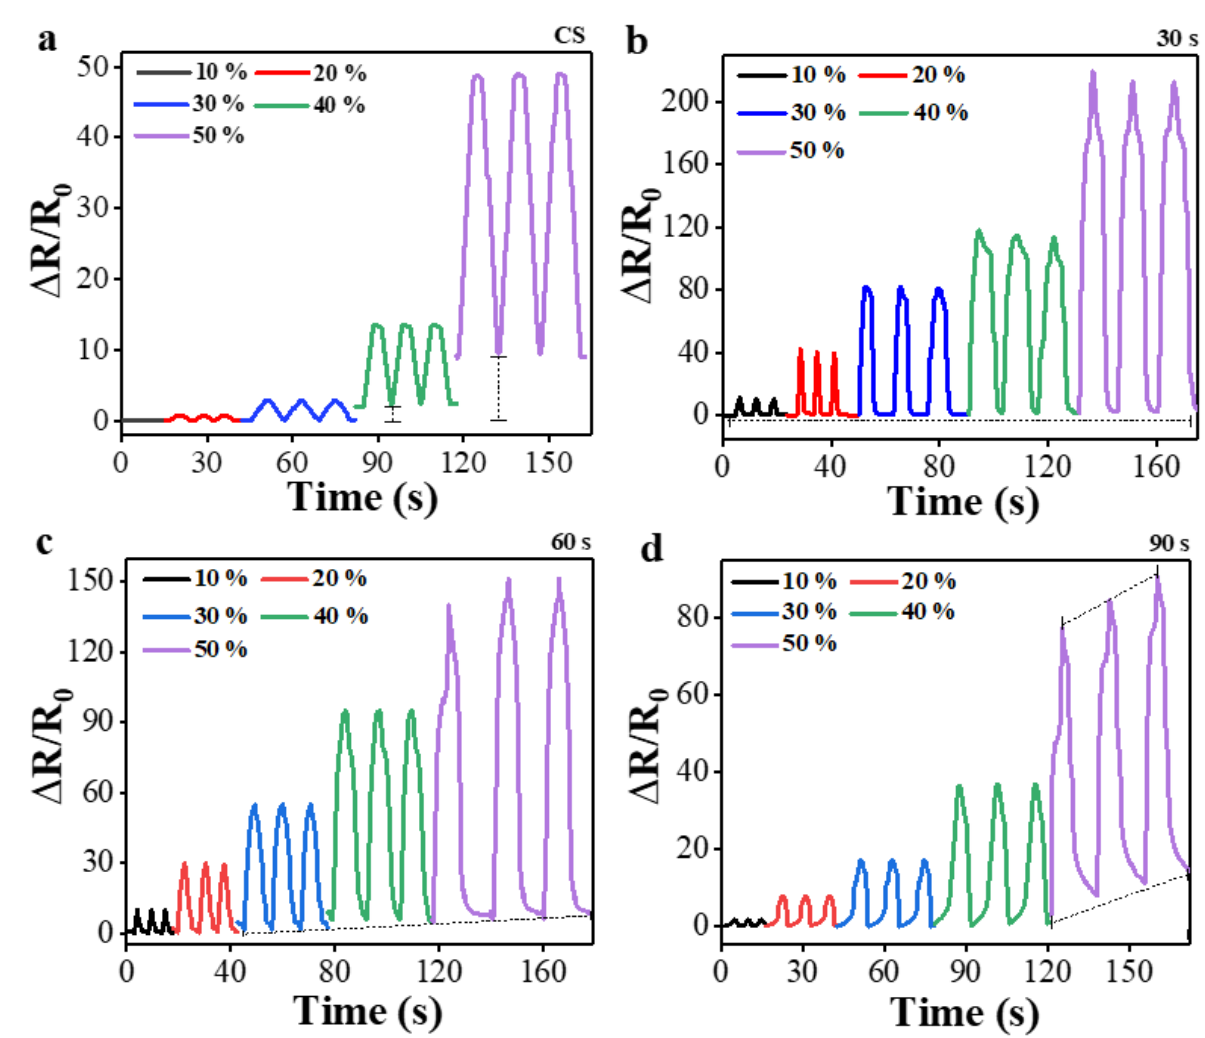
Figure 6. Responses of normalized resistances upon the cyclic strain measured from the PPy/PDMS strain sensors fabricated with various PT time intervals of ( a ) 0 (CS) and ( b ) 30, ( c ) 60, and ( d ) 90 s. In these cyclic tests, the peak strain was varied from 10 to 50% with a stepwise increase of